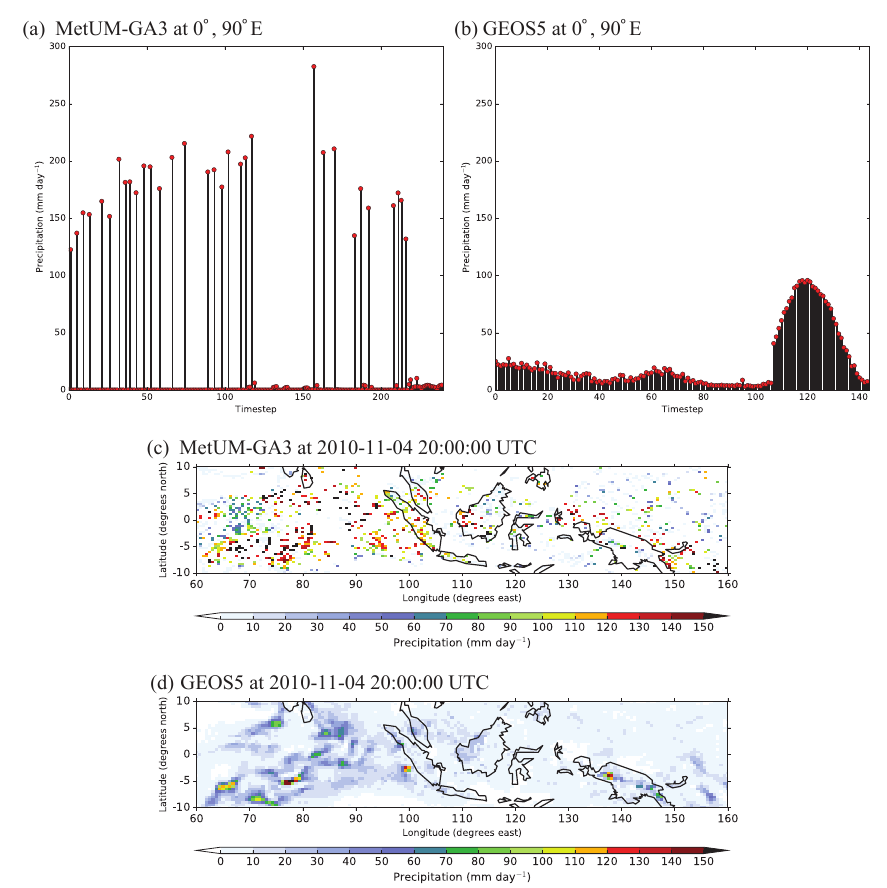
Figure 7. For (a) MetUM-GA3 and (b) GEOS5, time series of time step, gridpoint precipitation (mmday − 1 ) at the point 0, 90 ◦ E for the 48h forecast initialized at 00:00UTC 4 November 2010. Each red dot represents one time step; a red dot on the horizontal axis corresponds to zero precipitation. The series covers 48h for both models, which corresponds to 240 time steps in MetUM-GA3 and 144 time steps in GEOS5; the width of the vertical bars has been scaled for the difference in time step length. For (c) MetUM-GA3 and (d) GEOS5, maps of instantaneous precipitation rates at the time step corresponding to 20:00UTC on 4 November 2010, from the forecast initialized on 00:00UTC on 4 November